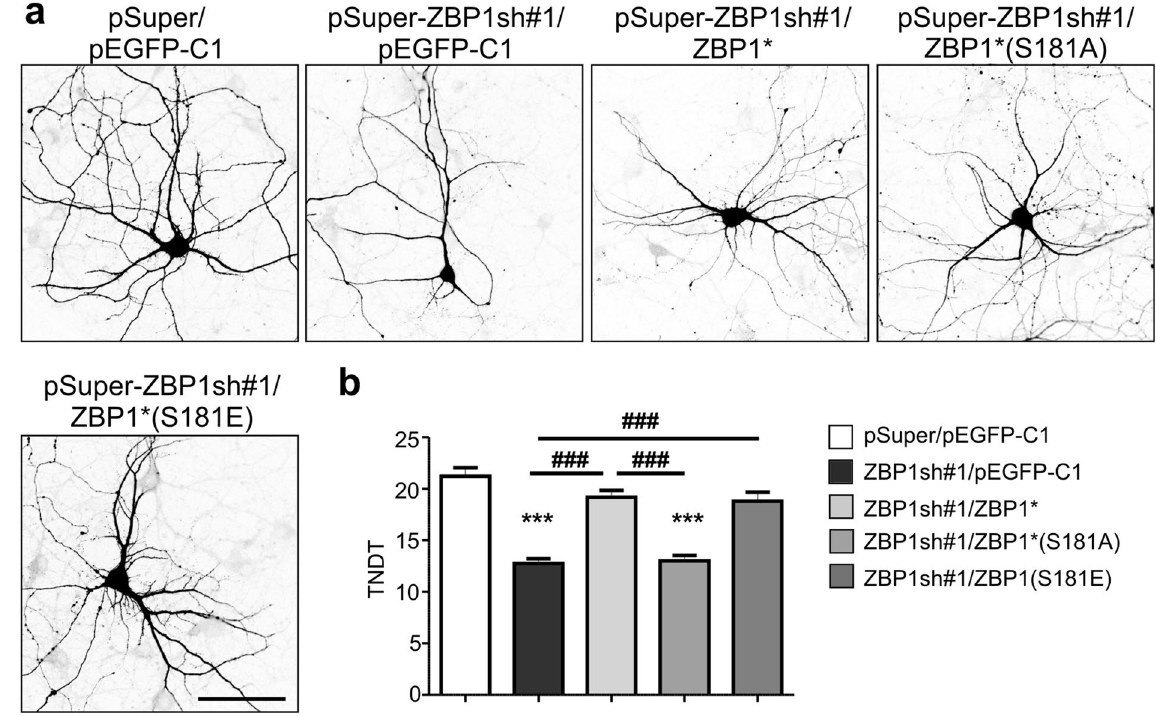
Figure 3. ZBP1 phosphorylation at Ser181 is needed for the proper dendritic arborization of hippocampal neurons. ( a ) Representative confocal images of cultured hippocampal neurons transfected on DIV8 for 2 days as indicated. Neuron morphology was visualized by co-transfection with mRFP. Scale bar = 50 µ m. ( b ) Total number of dendritic tips (TNDT) of neurons transfected as in ( a ). The data are expressed as mean ± SEM. *** p < 0.001, compared with pSuper/pEGFP-C1-transfected cells; ### p < 0.001, compared as indicated (Kruskal-Wallis test followed by Dunn’s post hoc test). Cell images were obtained from two independent culture batches. Number of cells per variant: pSuper/pEGFP-C1 ( n = 35), ZBP1sh#1/pEGFP-C1 ( n = 36), ZBP1sh#1/ pEGFP-ZBP1 * ( n = 35), ZBP1sh#1/pEGFP-ZBP1 * S181A ( n = 55), and ZBP1sh#1/pEGFP-ZBP1 * S181E ( n =